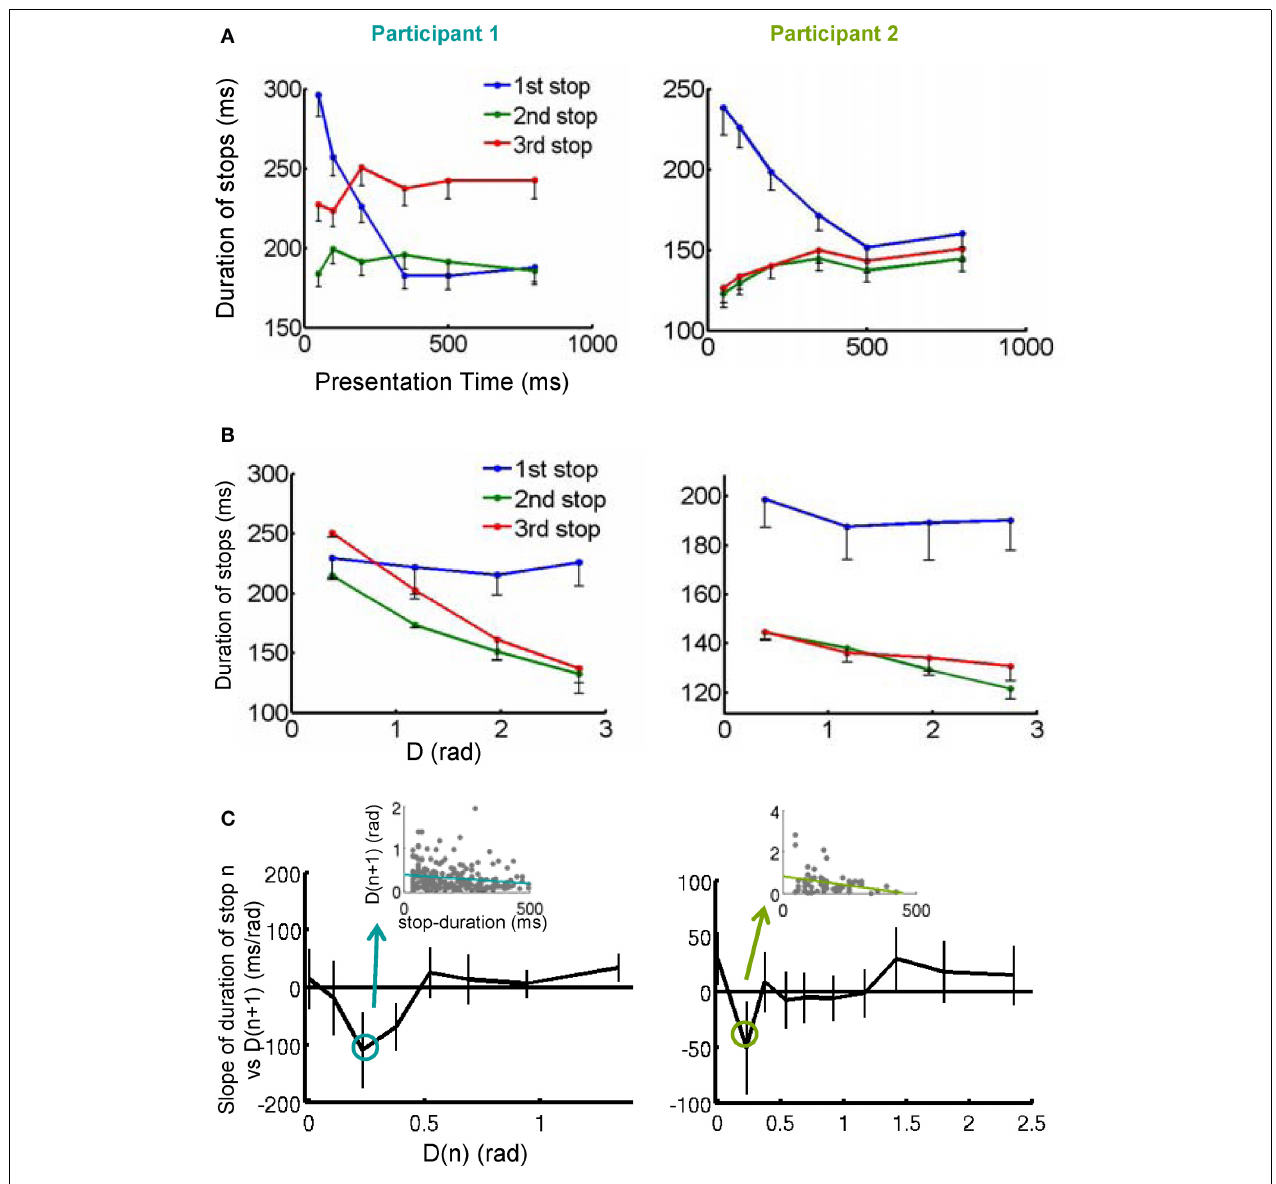
D ( n + 1). Error bars represents the 95% confidence interval. Additionally, the inset shows an example of the negative correlation obtained in